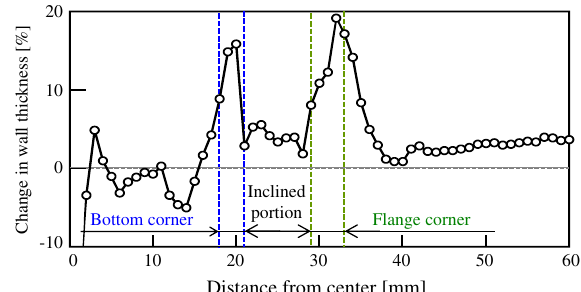
Figure 19. Distribution of change in wall thickness of disk with 590 MPa steel blank having 1 mm of